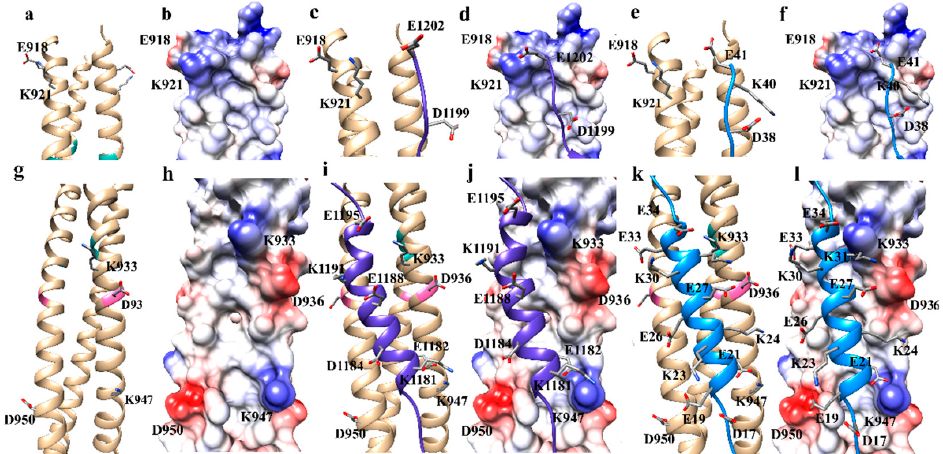
Figure 6. Electrostatic interactions between SARS-CoV-2 WT HR1 and HR2 domains and SARS-CoV-2 WT HR1 domain and EK1 peptide shown as either ribbon diagrams or electrostatic potential plot formats. In electrostatic plots, red color indicates regions of negative charge, blue indicates regions of positive charge, and white color indicates regions of neutral charge. ( a , b ) SARS-CoV-2 WT HR1 binding region that interacts with the C terminal portion of the peptides. ( c , d ) C terminal region of the HR2 and SARS-CoV-2 HR1 WT domain. ( e , f ) C terminal region of the SARS-CoV-2 WT HR1 binding site and EK1. ( g , h ) Helix binding region of SARS-CoV-2 WT HR1 binding site and EK1. ( i , j ) SARS-CoV-2 WT HR1 and helix region of HR2 domain. ( k , l ) SARS-CoV-2 WT HR1 and helix region of EK1. Region corresponding to the binding site for the N terminal portion of SARS-CoV-2 not shown.